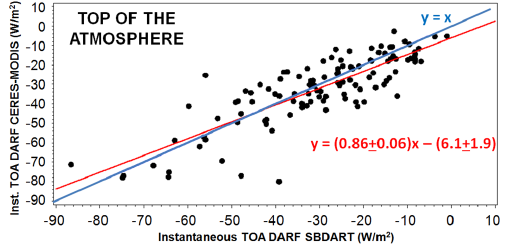
Figure 8. Intercomparison between the instantaneous direct aerosol radiative forcing (DARF) at the top of the atmosphere (TOA) eval- uated using CERES-MODIS and modelled using AERONET and MODIS BRDF retrieved optical properties as inputs in SBDART.